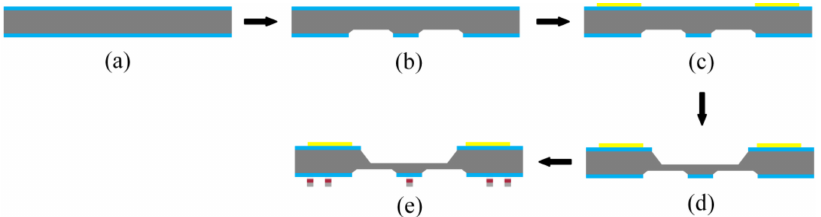
Figure 2. Schematic of the process for fabrication of the silicon cap. ( a ) Depositing the double-side SiNx. ( b ) Etching the front pressure cavity. ( c ) Sputtering the back metal ring. ( d ) Etching the back pressure cavity. ( e ) Evaporating the bump and sealing rings.